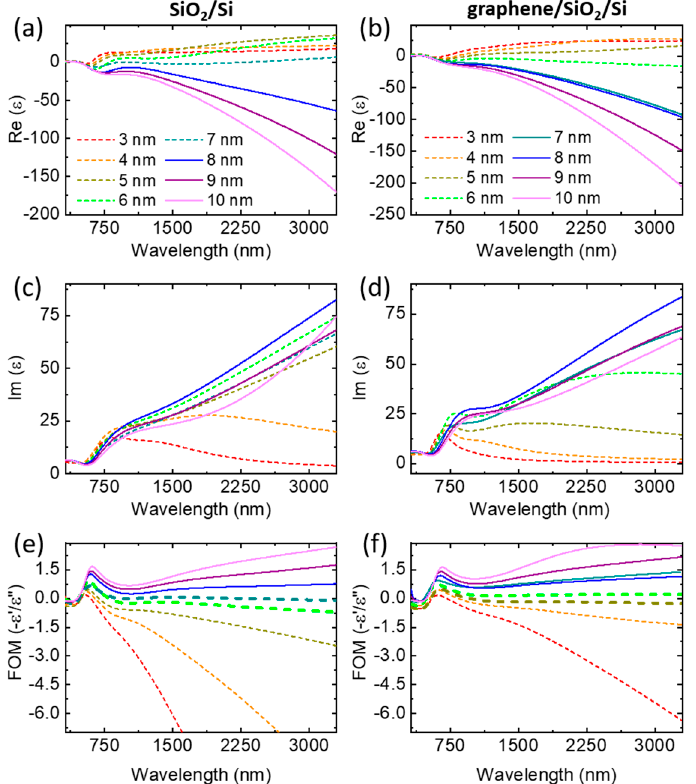
Figure 4. Dependence of the real and imaginary parts of the dielectric function on the thicknesses of gold films deposited on ( a , c ) SiO 2 / Si and ( b , d ) graphene / SiO 2 / Si substrates. FOM for gold films on ( e ) SiO 2 / Si and ( f ) graphene / SiO 2 / Si substrates. The dashed and solid lines correspond to percolated and continuous films, respectively.